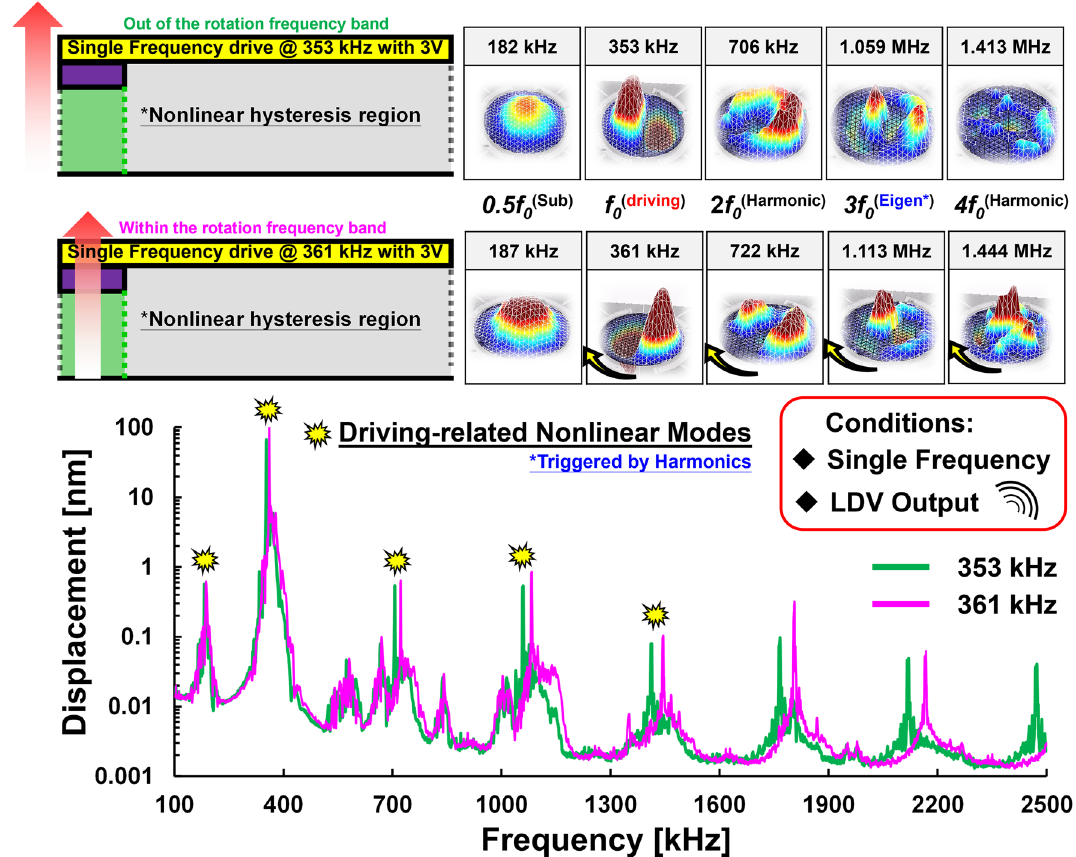
Figure 7. Mechanical motions driven within and out of the rotation frequency band: The mechanical motions were captured by LDV and driven at 353 kHz and 361 kHz, respectively. Note that the yellow dots identify the coherent integer frequencies and the motion at 3 f 0 presents the normal (1,2) mode triggered by the parametric